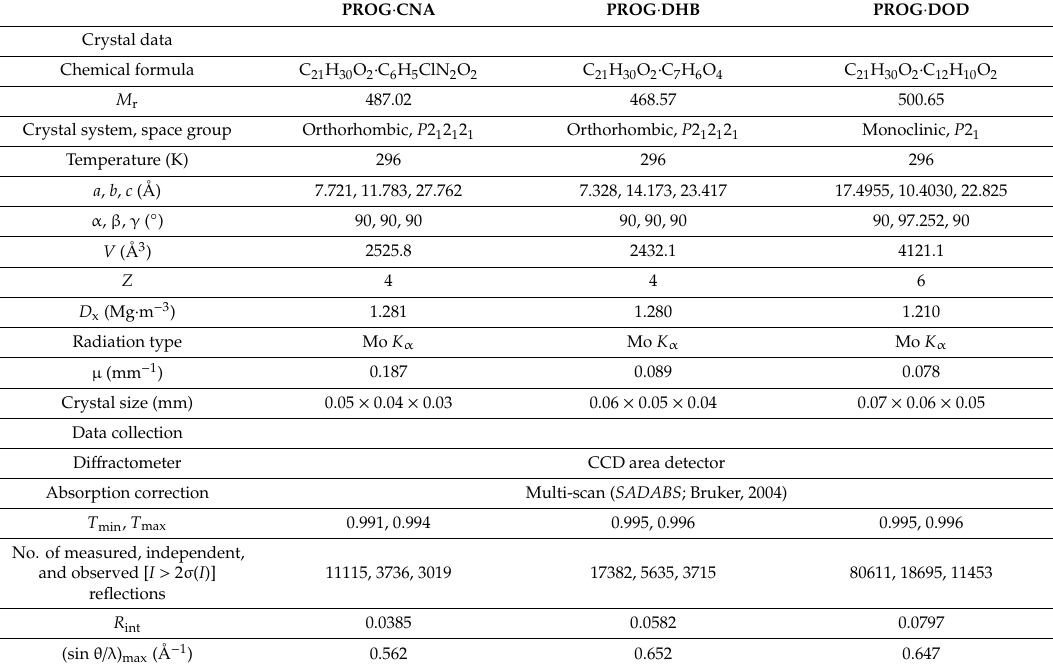
Table 4. Crystal data and the structure refinement